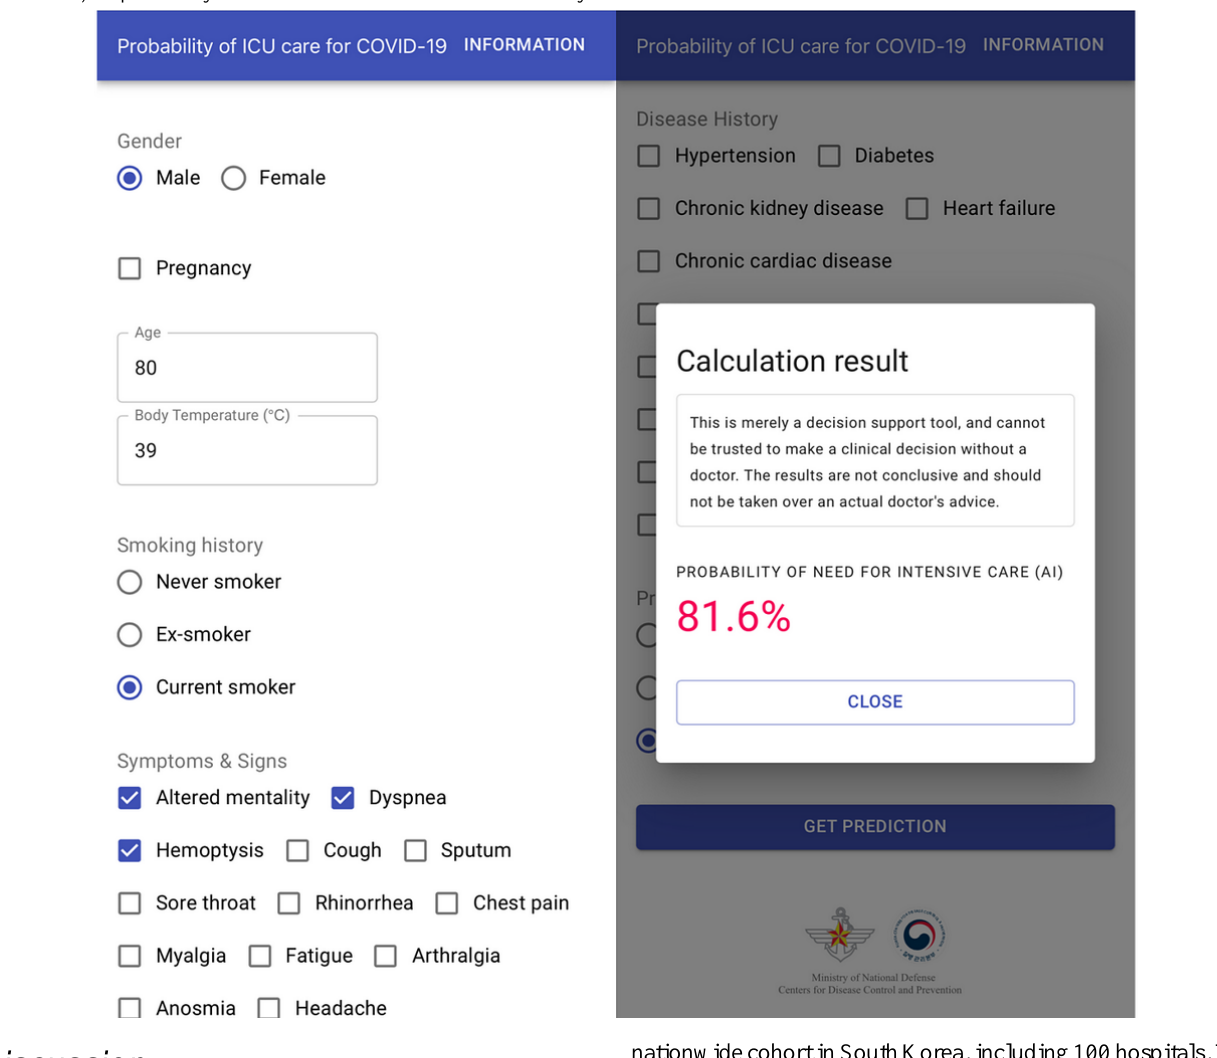
Figure 3. Screenshots of the web-based application for easy usage of the developed machine learning model [20]. After input of simple patient-derived information, the probability of the need for intensive care within 30 days is